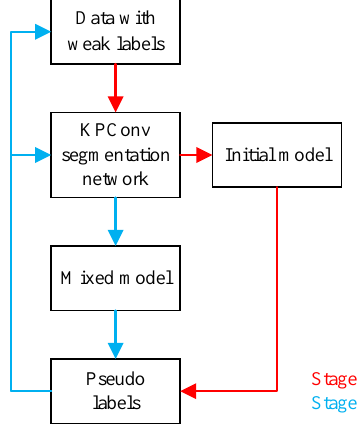
Figure 2. Architecture of the proposed